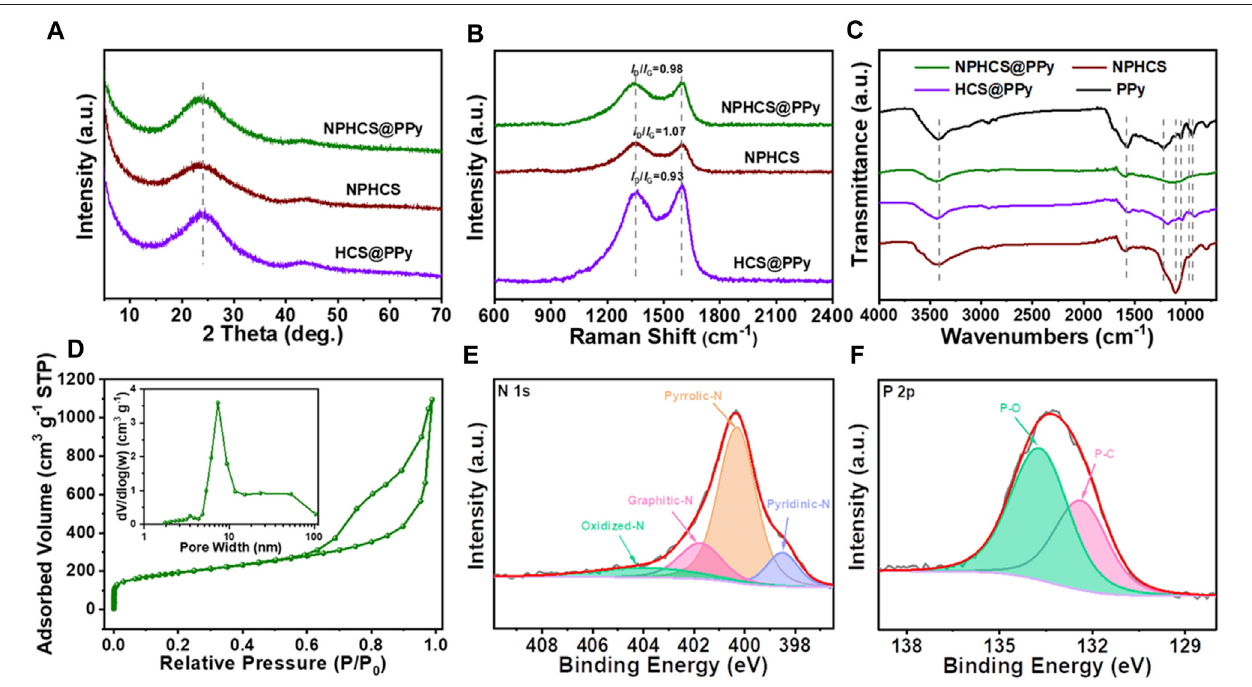
FIGURE2|(A) XRDpatternsand (B) RamanspectraofNPHCS@PPy,NPHCS,andHCS@PPy (C) FT-IRspectraofpurePPy,NPHCS@PPy,NPHCS,andHCS@ PPy (D) N 2 adsorption and desorption isotherms of NPHCS@PPy with the inset of their pore size distribution curves. High-resolution XPS spectrum of (E) N1s and (F) P2p for